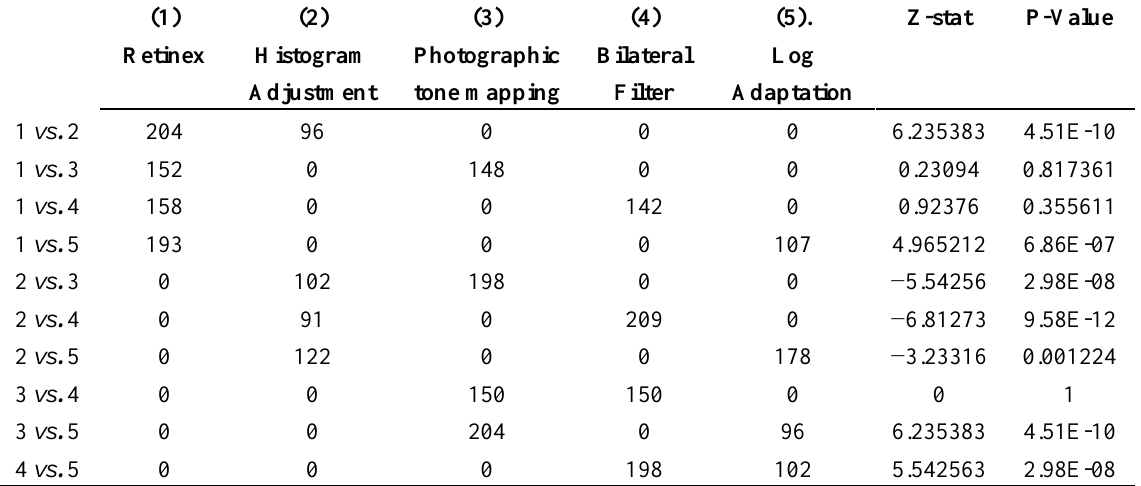
Table 1. Paired Comparison Results, z-statistics and p-values collapsed across participants and